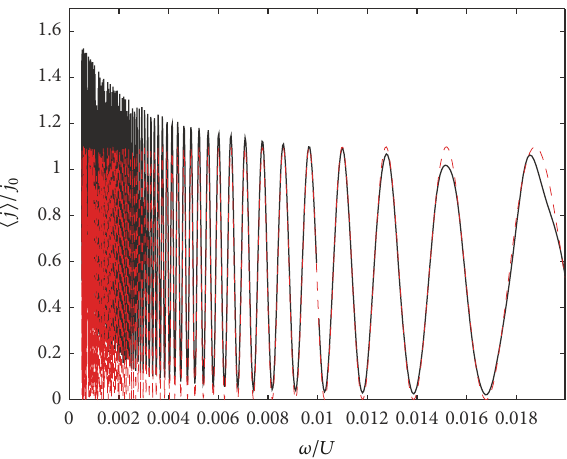
Figure 5: The dependence of the mean current on the oscillating frequency. The solid line represents the exact numerical solution, while the dashed (red) curve stands for the approximation. Equation (32) is multiplied by 1.1. The simulations parameters were 𝐿√𝑈 = 6 , /√𝑈 = 0.8 , Ω/𝑈 = 0.5 , and Δ𝑓/√𝑈 = 1.1 𝑓 0